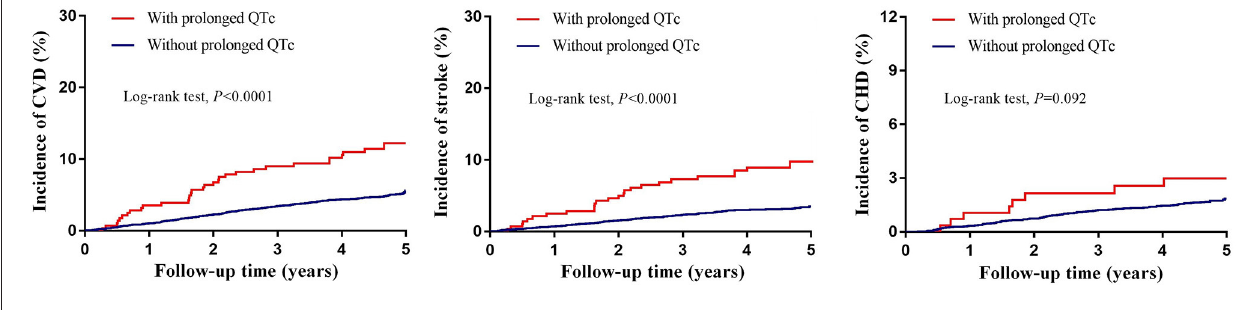
this method is known to potentially overestimate the number of patients with prolonged QTc interval and its association with outcomes (31, 32). Therefore, in the present study we used the Framingham formula, a linear regression method, to adjust the QT interval for heart rate, which has been recommended in recent guidelines